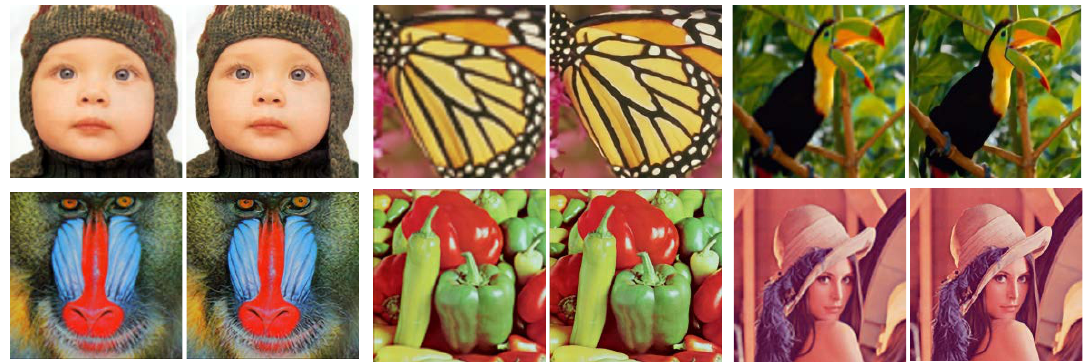
Figure 15. Super-resolution results of images in Set5 [47] and Set14 [46]. Our method takes the bicubic interpolation of low-resolution images ( left ) as input and high-resolution images ( right , 4 × ) as